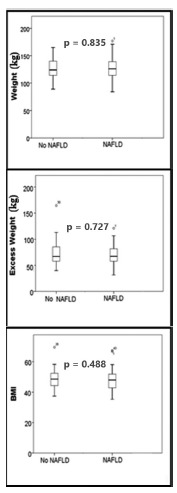
Boxplot comparisons of the weight, excess weight and body mass index (BMI) of individuals with and without non-alcoholic fatty liver disease (NAFLD). There was no significant difference in these parameters between the two groups (p = 0.835, p = 0.727 and p = 0.488 for weight, excess weight and BMI, respectively). Statistical comparisons were done using the Mann Whitney U test with p<0.05 indicating significance.